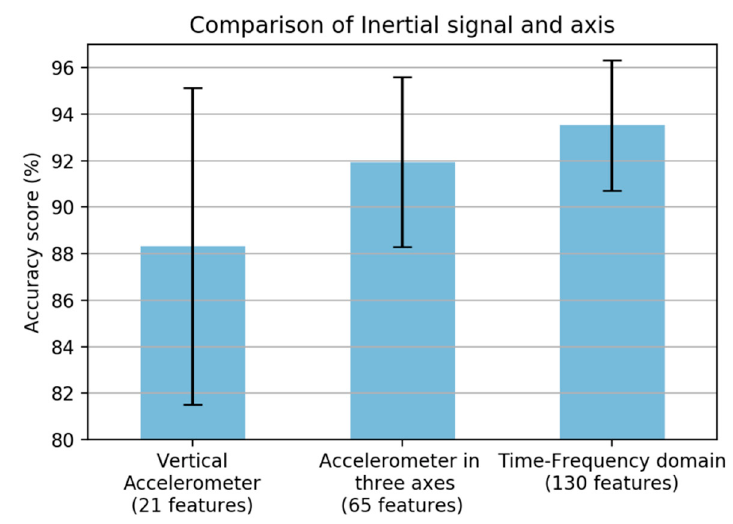
Figure 4. Comparison of inertial sensor and axis.